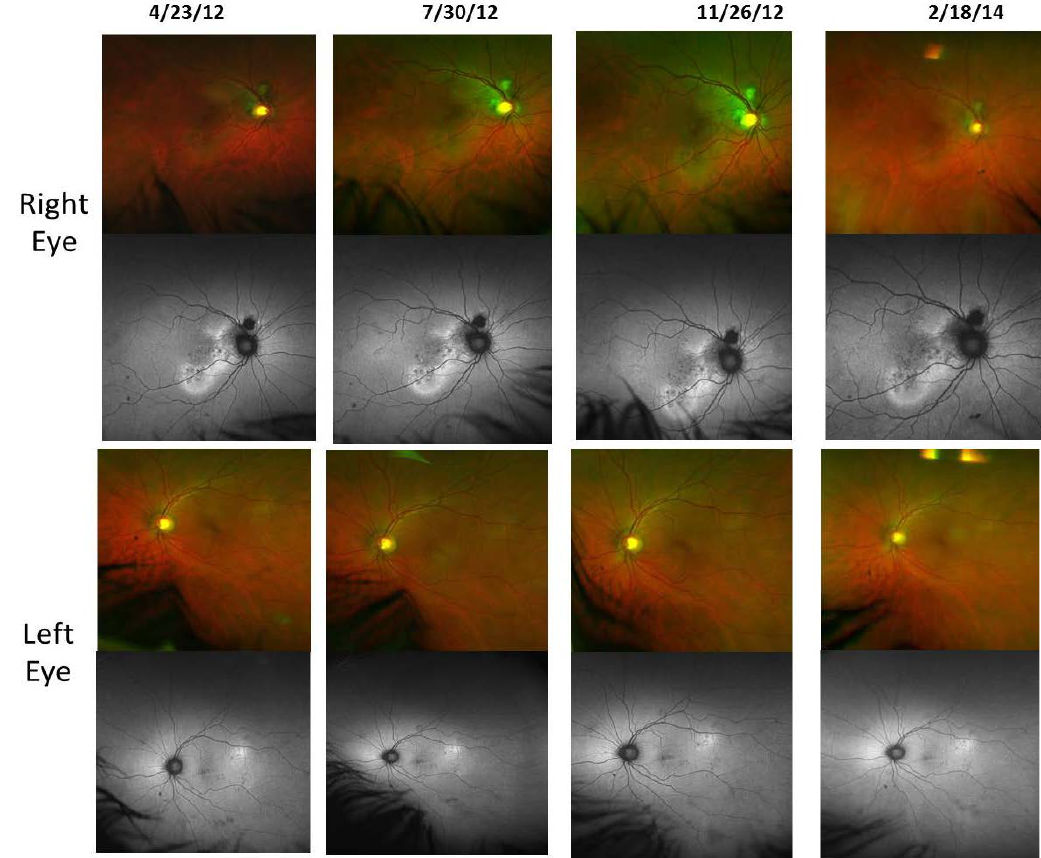
Figure 9. Wide Field OPTOS ® FAF Images of Lipofuscin within the Neurosensory Retina of a 67-year-old male with Polypoidal Choroidal Vasculopathy (PCV), a “treatment resistant” AMD variant. No fluorescein angiography was possible due to a previous allergic reaction to iodine. There is a decrease in auto fluorescence evident in his right retina by Month